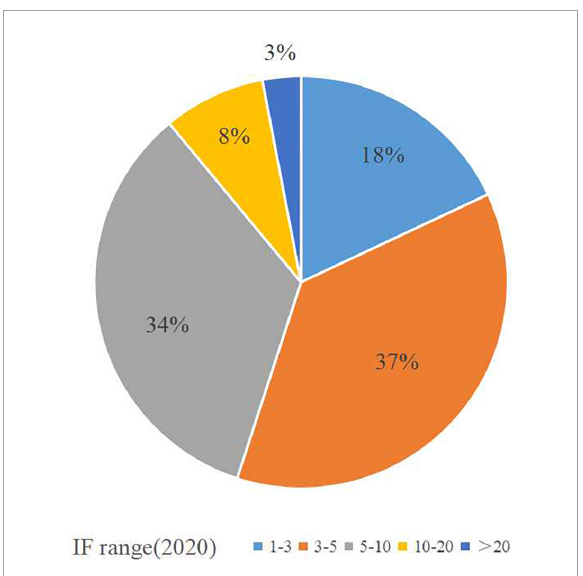
FIGURE6 The number of articles corresponding to different IF in the top 100 most-cited papers.